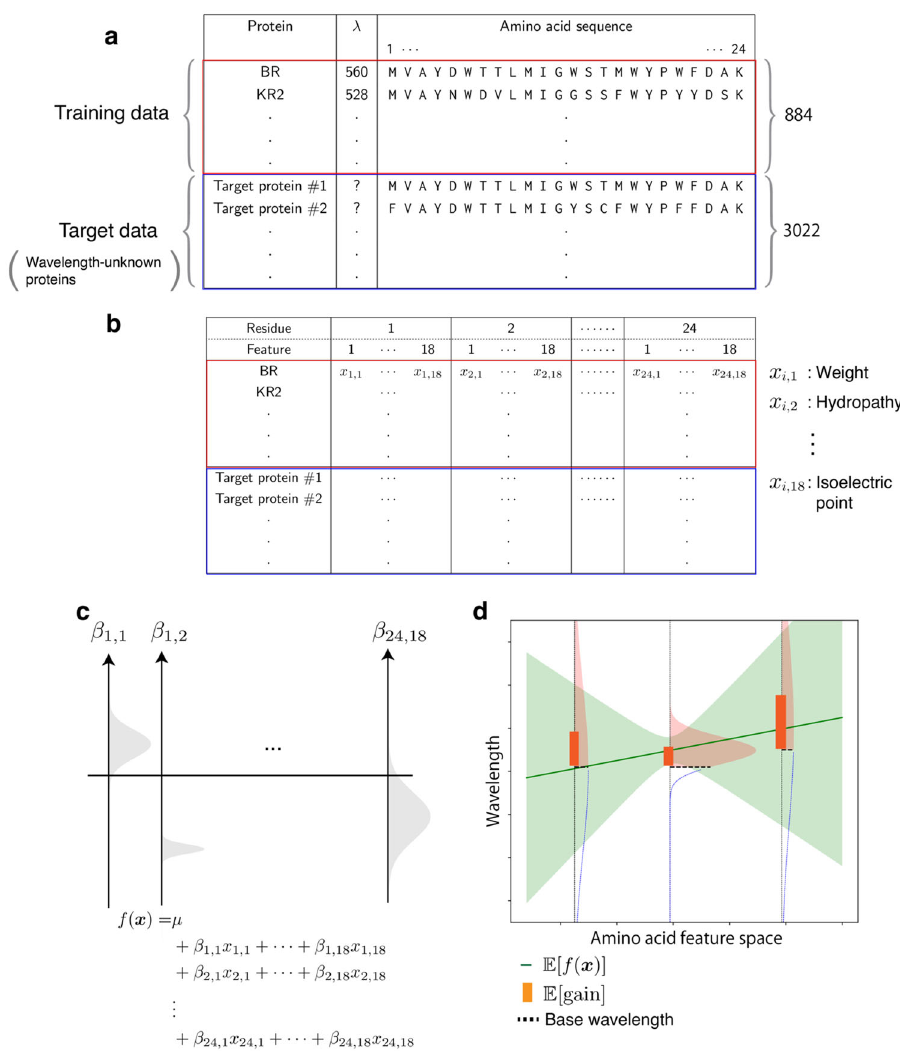
Fig. 3 Overview of the ML-based exploration of natural red-shifted rhodopsins. a Using existing experimental data, a training data set consisting of pairs of a wavelength λ max and an amino acid sequence was constructed. A particular focus was placed on the 24 amino acid residues around the retinal chromophore to build an ML-based prediction model. A set of protein sequences with no known wavelength was also collected as target proteins. b All amino acid sequences were transformed into physicochemical features, leading to 24 ×18 = 432 dimensional numerical representations of each protein. c A linear regression model was constructed using the Bayesian approach. Each regression coef fi cient β i , j was estimated as a distribution (shown as a gray region). The broadness of these distributions represent the uncertainty of the current estimation. d The expected red-shift gain values were evaluated for the target proteins. The green region is the standard deviation of the prediction. The red shaded region in the vertical distribution corresponds to the probability that the wavelength is larger than the base wavelength (dashed line), which is determined by the subfamily of the microbial rhodopsin. The bar represents the expected red-shift gain, de fi ned by the expected value of the increase from the base